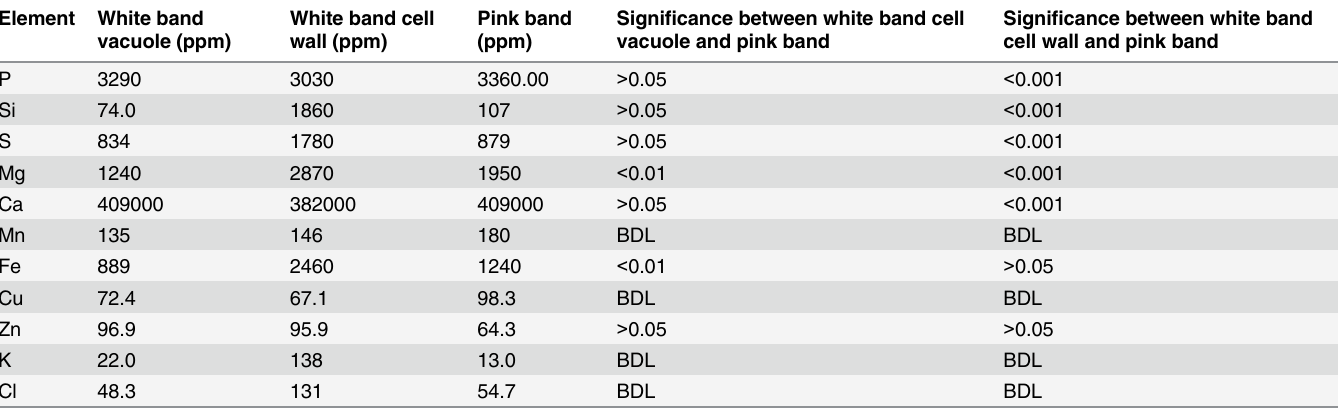
Elemental abundances in pink and white bands indicated by EPMA. BDL indicates a value is below the detection limit for that